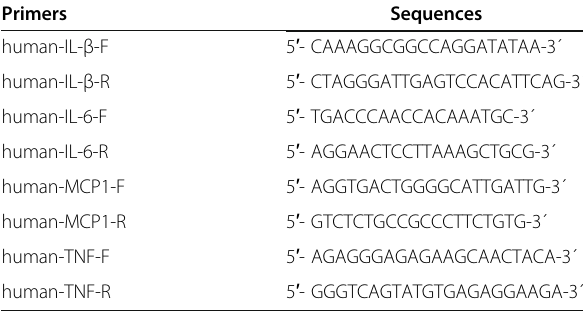
Table 1 qPCR primers used in the present study